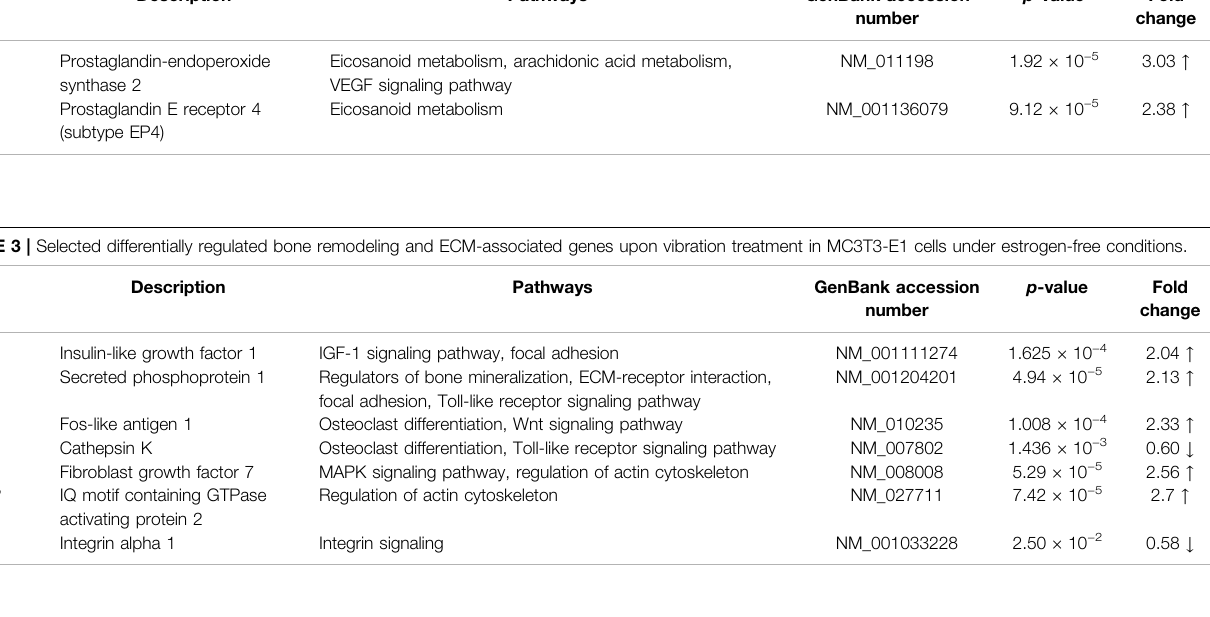
TABLE 2 | Selected differentially regulated mechanosensitive genes upon vibration treatment in MC3T3-E1 cells under estrogen-free conditions. Gene